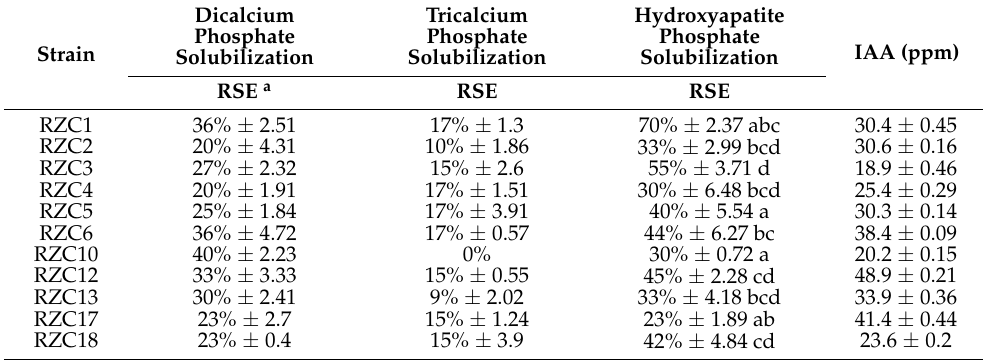
Table 3. PGPR activities of rhizobia strains isolated from soils samples collected from Chanchamayo. Strain